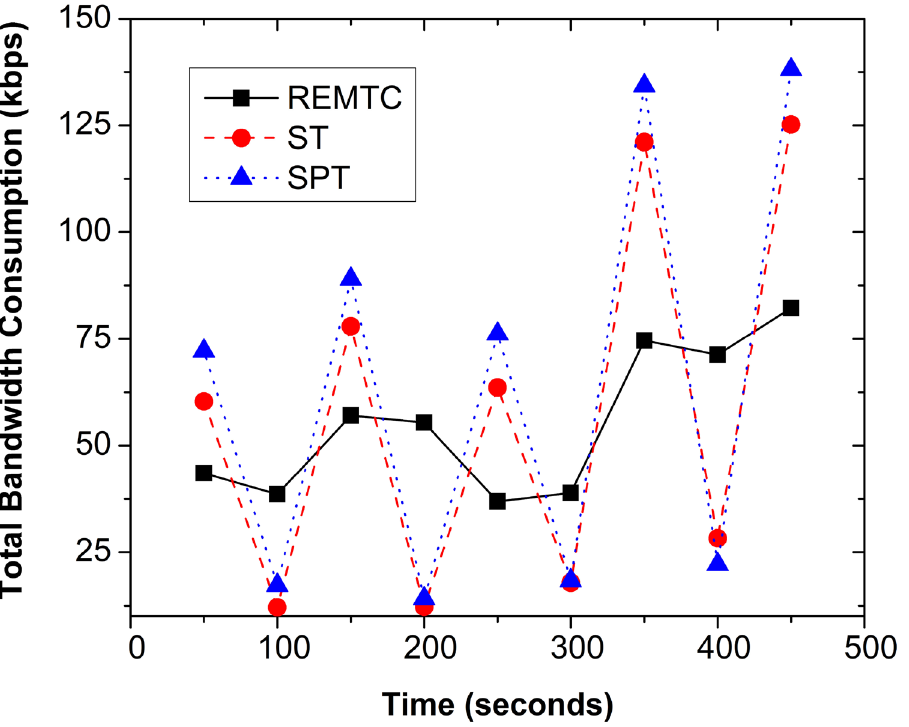
Figure 6. Bandwidth consumption in experimental